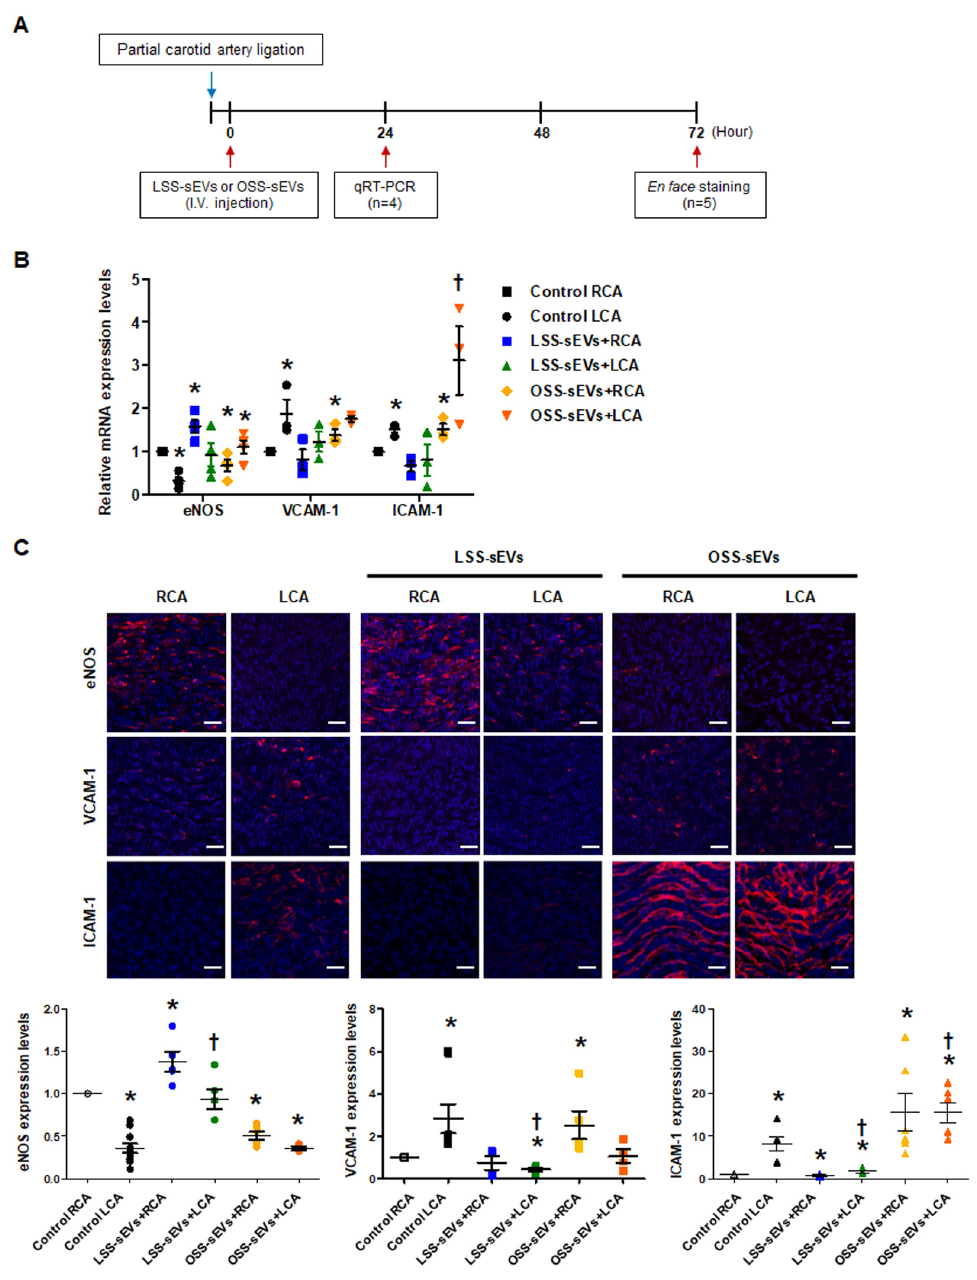
Figure 5. Effects of shear stress-induced EC-sEVs on distant endothelium in vivo. ( A ) Experimental design illustrating the treatment and analysis schedule for animal experiments. The LCA of wild-type (WT) C57BL/6 mice ( n = 9 per group) were partially ligated. The iMAEC-derived LSS- or OSS-sEVs (500 μ g) were injected intravenously twice a day into mice with LCA partial ligation. ( B ) Twenty-four hours after LCA ligation, mice were sacrificed, and EC-enriched RNA was extracted from both carotid arteries. The mRNA levels encoding eNOS, VCAM-1, and ICAM-1 in EC-enriched RNA were determined using real-time PCR ( n = 4; * p < 0.05 compared to control RCA; † p < 0.05 compared to control LCA). Mean ± SEM. ( C ) Three days after LCA ligation, immunofluorescence staining was performed in carotid arteries from untreated mice and mice injected with shear stress-induced EC-sEVs. Representative images are shown (red, eNOS, VCAM-1, or ICAM-1; blue, nuclei; scale bars, 10 μ m) ( n = 5; * p < 0.05 compared to control RCA; † p < 0.05 compared to control LCA). Mean ± SEM. Statistical analysis was performed using the nonparametric Mann–Whitney U test.